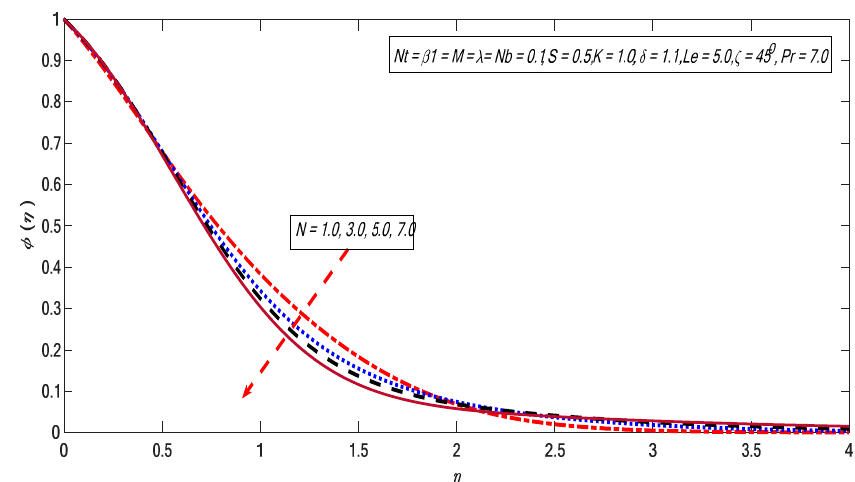
Figure 18. Variations in concentration profile for several values of 𝑁 . Appl. Sci. 2019 , 9 , x FOR PEER REVIEW